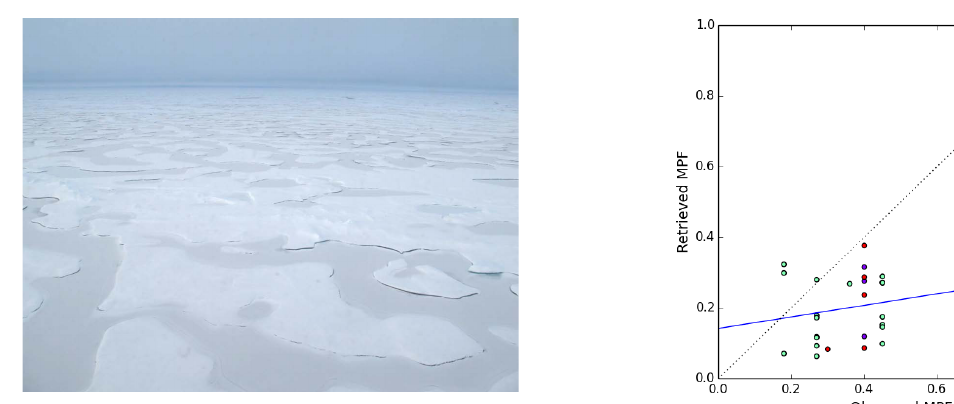
Figure 17. Retrieved MPF vs. observed MPF from the hourly bridge observations during TransArc 2011, 4 August 2011–6 Oc- tober 2011. Swath data, no temporal averaging, 15km satellite av- erage around the in situ point. All but one point is FYI. Corrected for ice concentration. Underestimation may be connected to undoc- umented presence of melted through or over-frozen ponds at the end of the melt season (see Fig. 16). R 2 = 0.026, RMS = 0.19, N = 26.